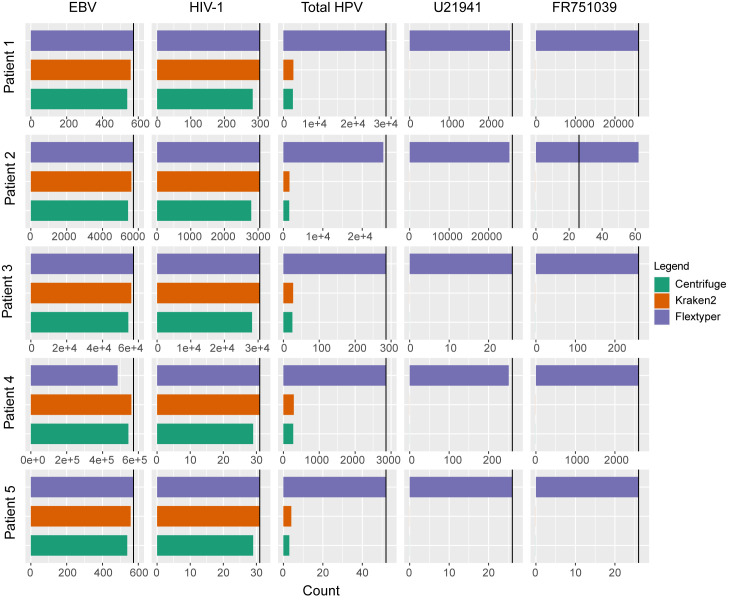
Mixed Viral Analysis.Detection of pathogen sequences in five synthetic patient RNA-seq datasets (Patient 1–5; rows), each with different levels of spiked-in viruses (EBV, HIV-1, U21941, and FR751039; columns), expected values shown as black vertical bars. As Centrifuge and Kraken2 are unable to delineate between the two HPV substrains (U21941 and FR751039), a combined count at the HPV level is tabulated.